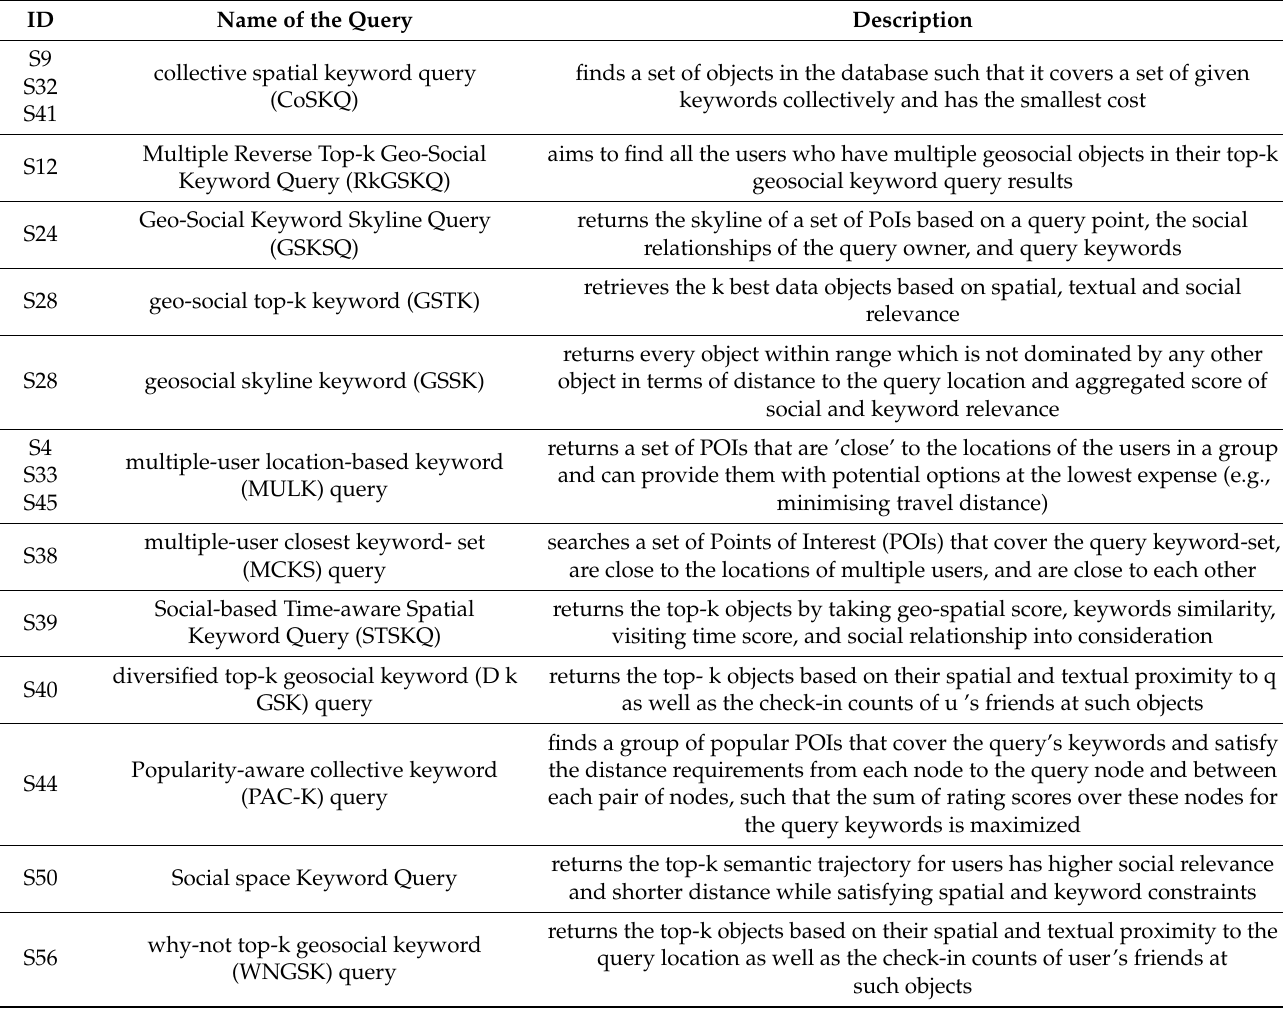
Table 8. Geosocial keyword